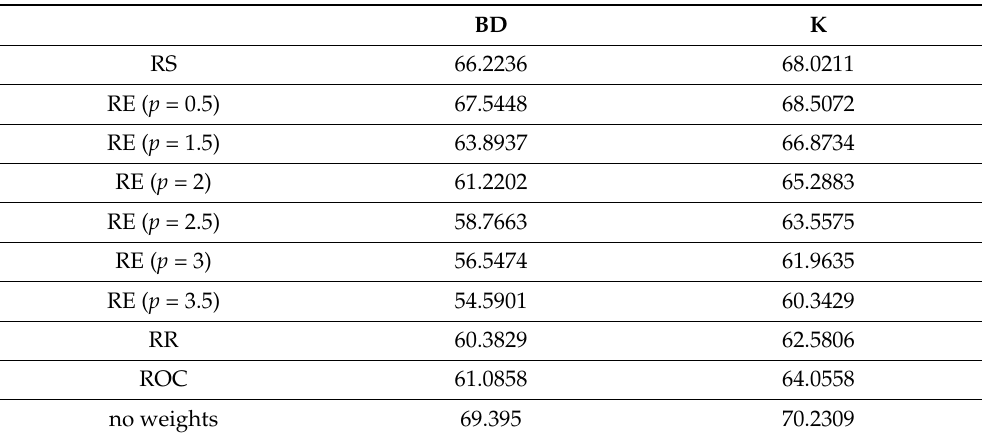
Table 7. Economic KPI medians ( KPI E